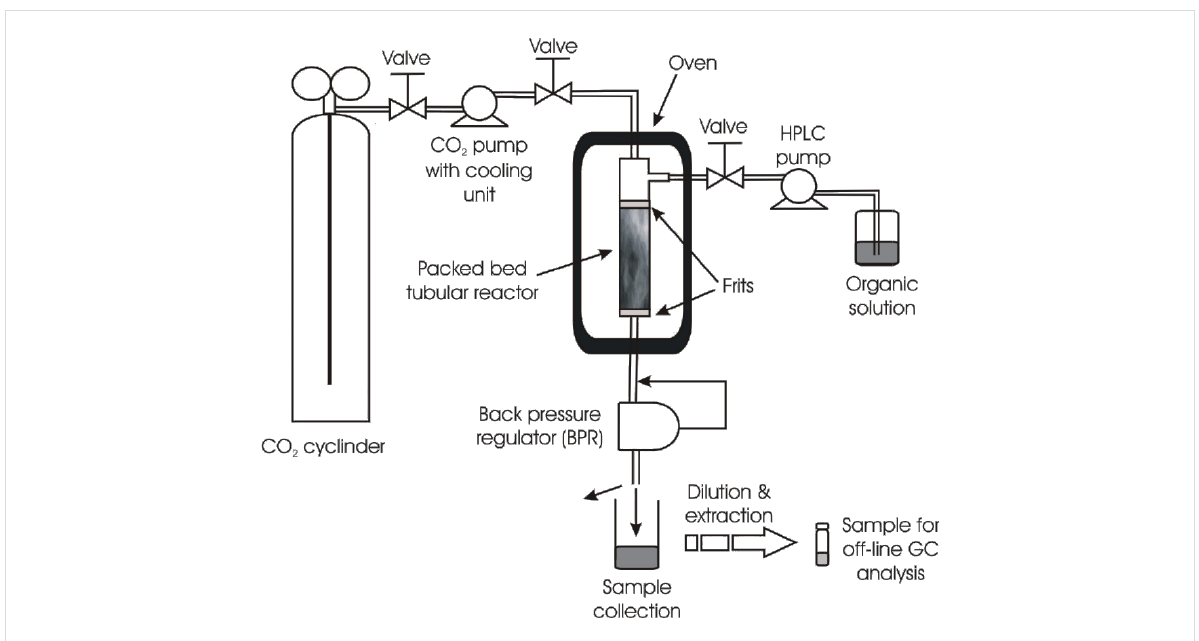
Figure 2: Schematic diagram of the continuous flow system. The reactor shown is the 3.9 mm i.d. PFR. For the 1 mm i.d. reactor this was a coil of the 300 cm or 100 cm tube according to the specific